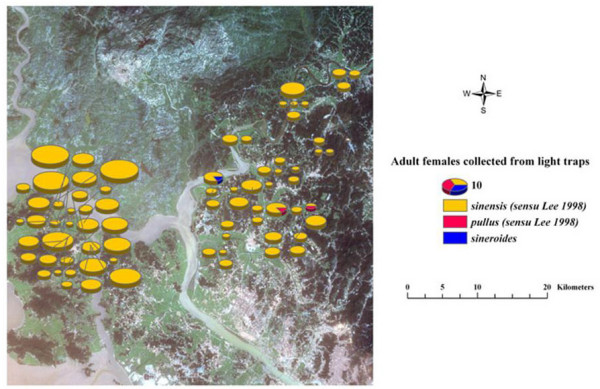
Adult females collected in light traps. Thematic map shows total numbers of adult anophelines collected in light traps during 32 nights during August-September 2003 overlaid on LANDSAT 7 satellite data (dated 10 September 2002, spatial resolution 30 × 30 meters) displayed in true color (band combination 3,2,1).